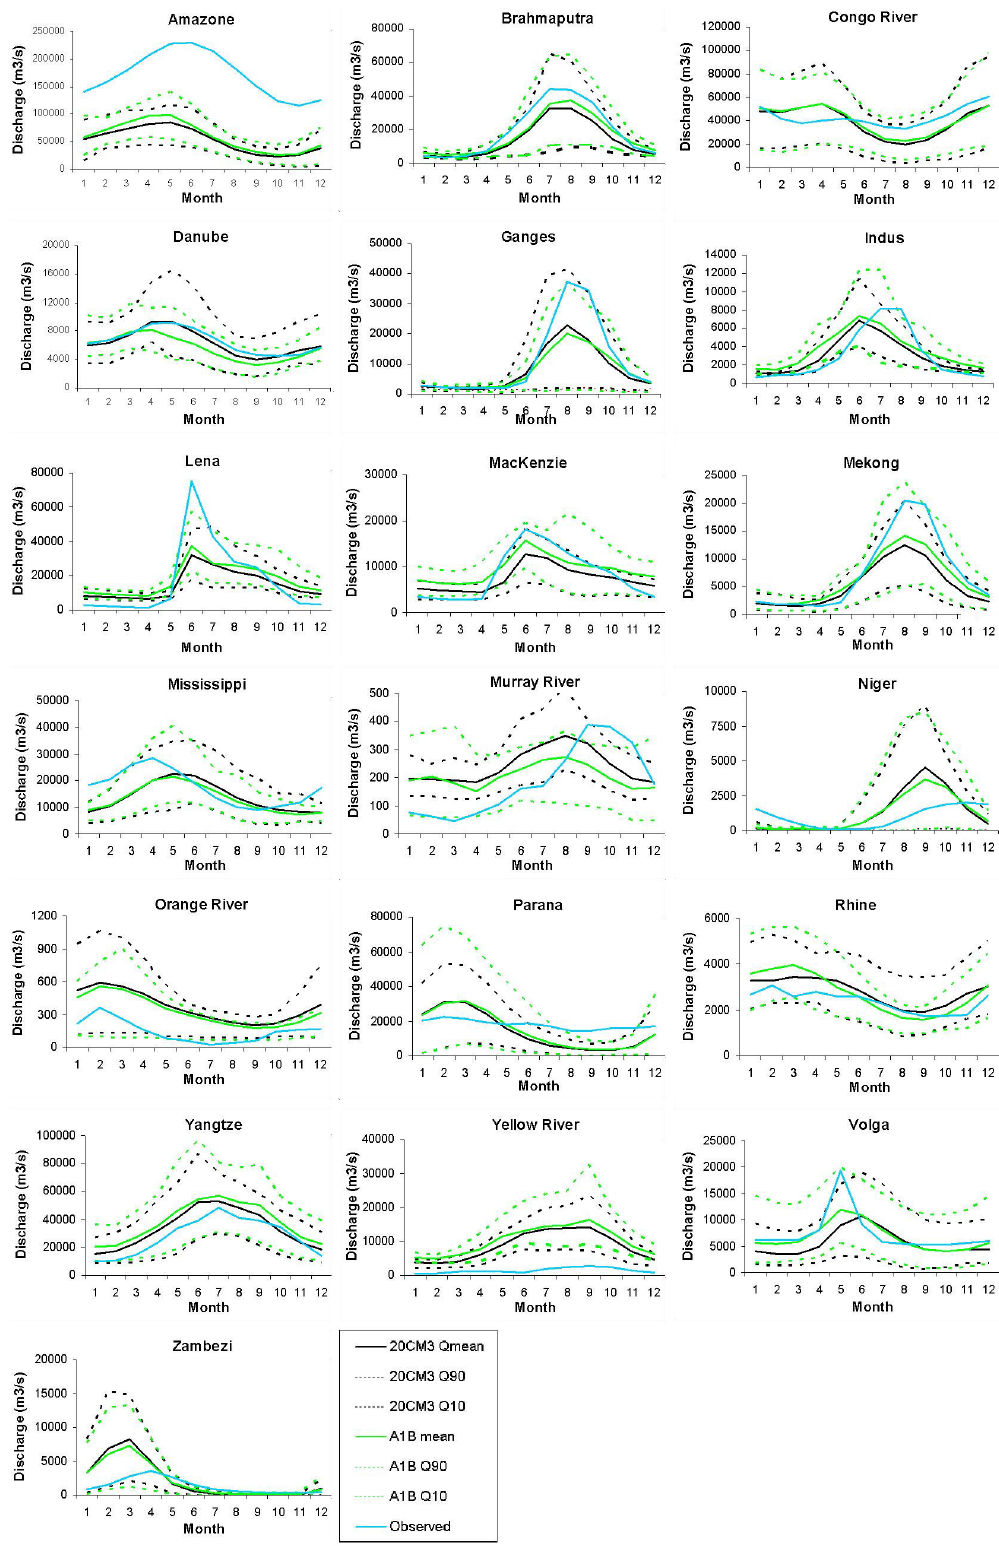
Fig. 10. Modeled annual hydrological cycles for the 19 selected catchments, showing for each experiment the monthly 20-yr average discharge and the monthly 10th and 90th percentile discharge derived from the discharges calculated from the 12 GCM datasets.